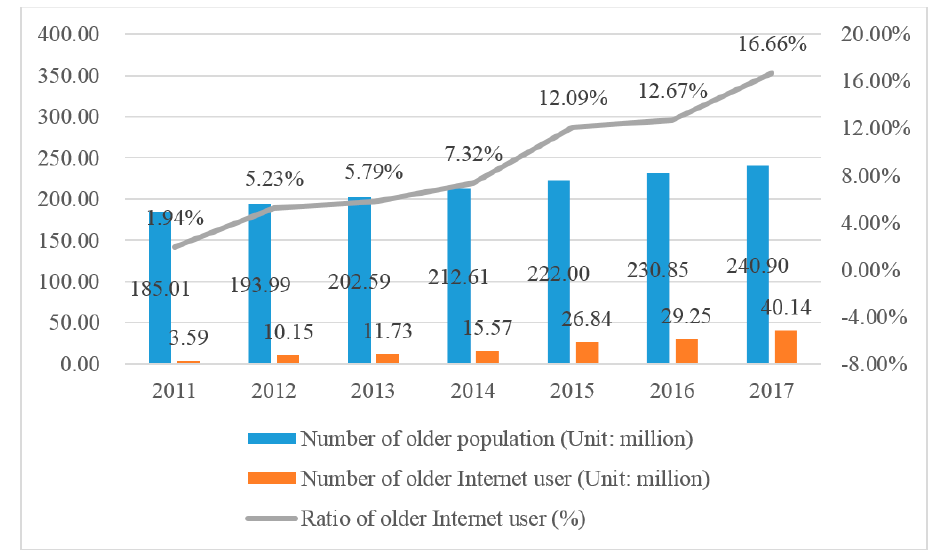
Figure 2. The change of mobile Internet users from 2011 to 2017 in China. Data from China Internet Network Information Center.